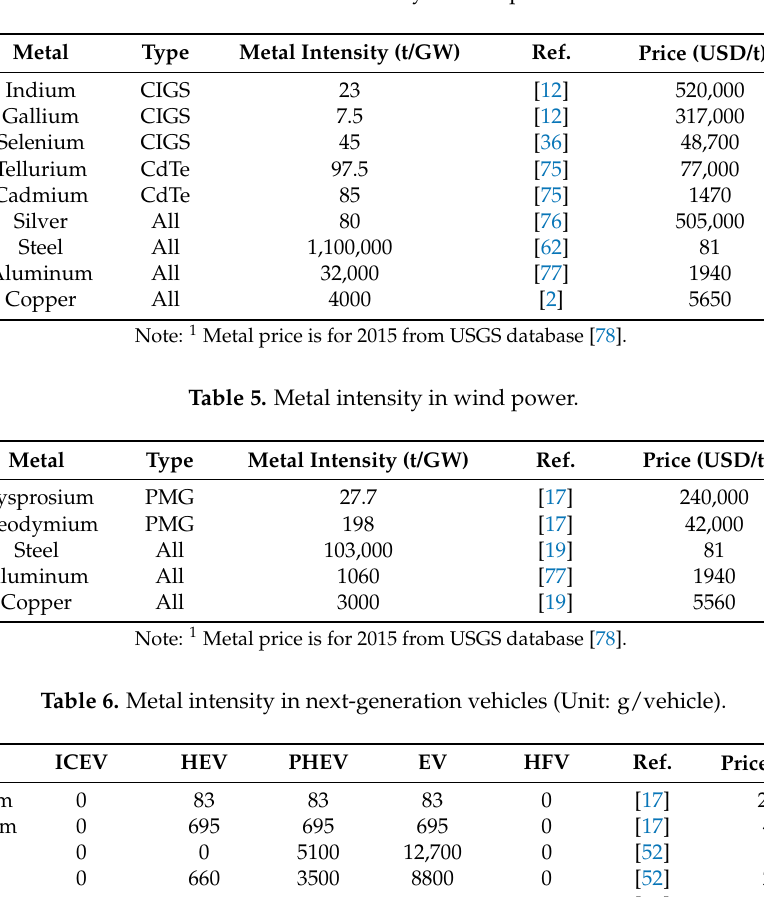
Table 4. Metal intensity in solar power.